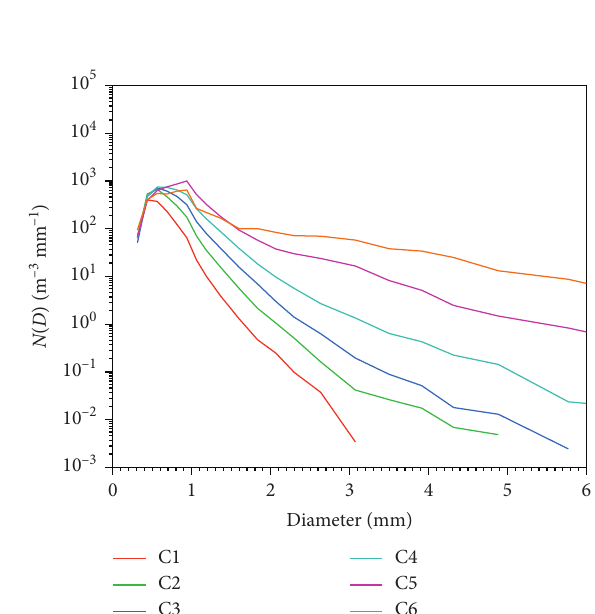
Figure 9: Average size spectra for different rain rate